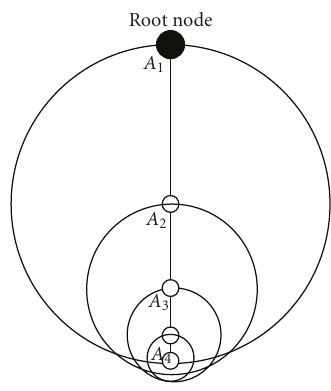
Figure 1: Worst-case scenario for timeslot reuse: the number